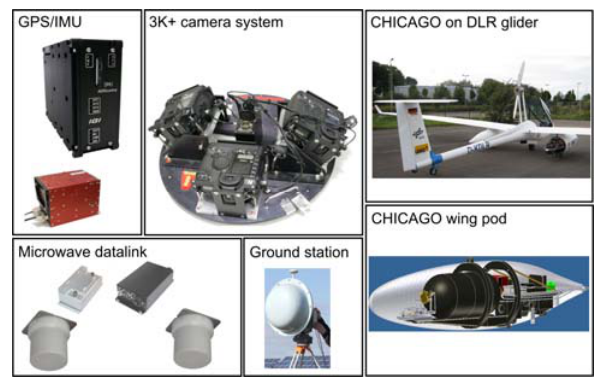
Figure 2. Airborne hardware components and data flow of the 3K camera system for the real time processing chain